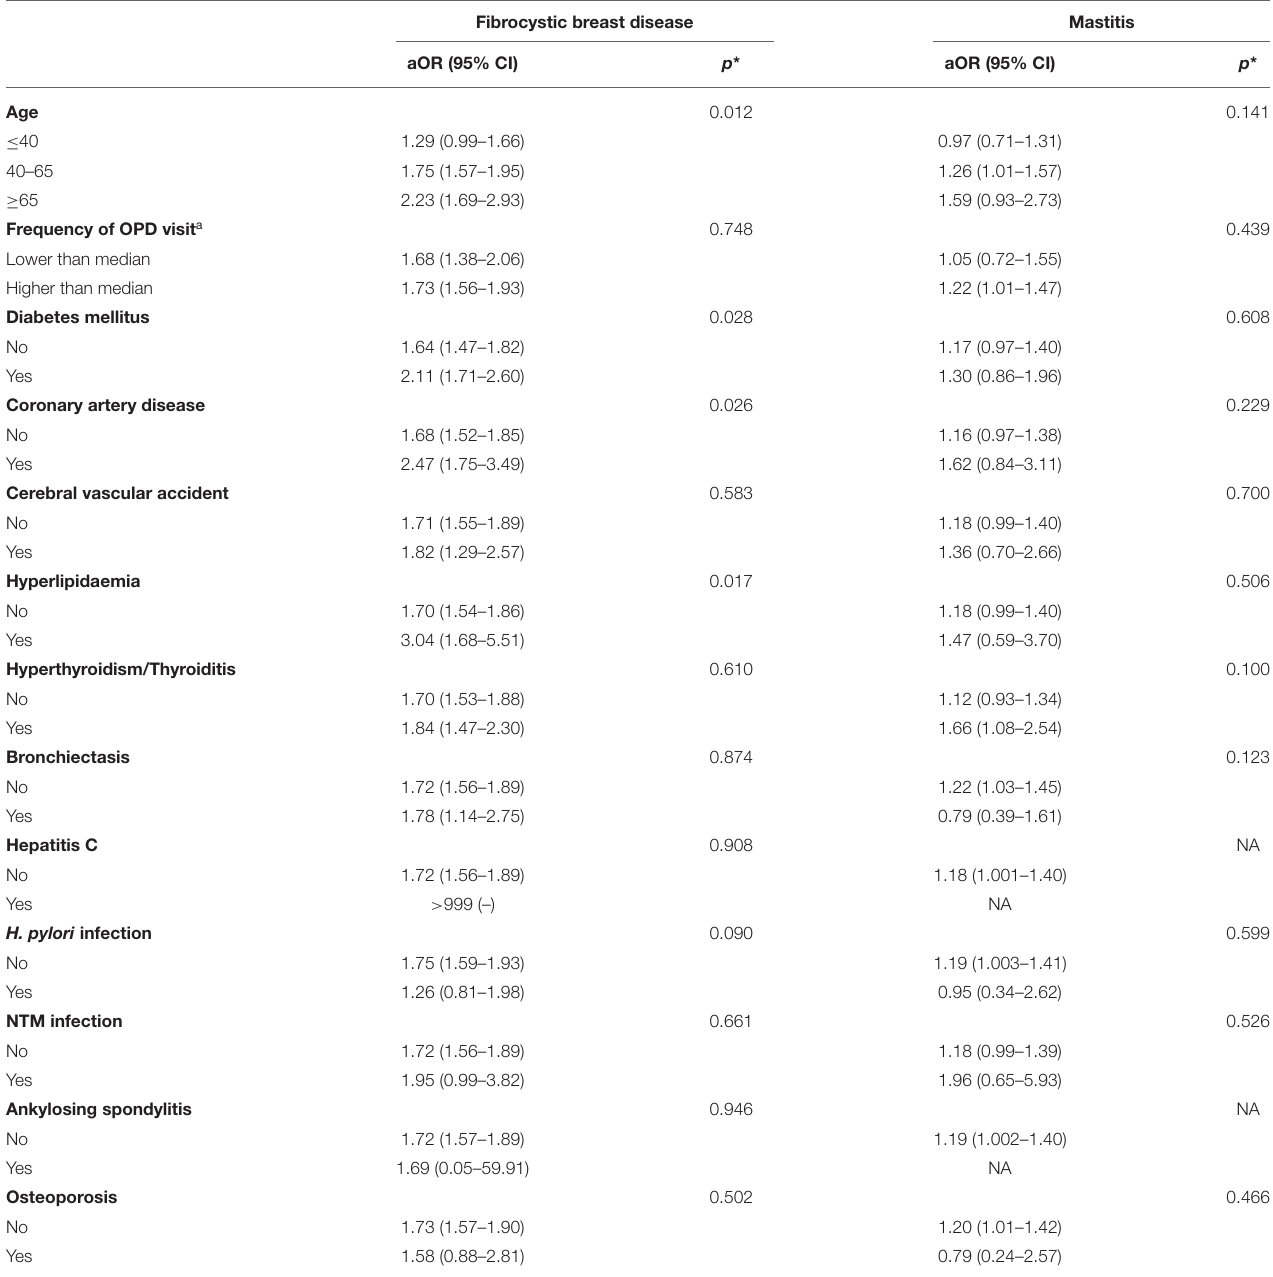
TABLE 4 | Stratified analyses for the association between benign breast diseases and Sjogren’s syndrome risk (1:2 propensity score matched